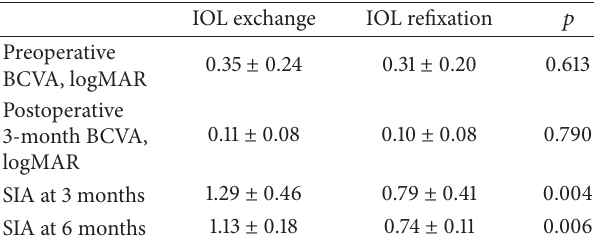
Table 3: Visual outcomes and SIA after scleral fixation of